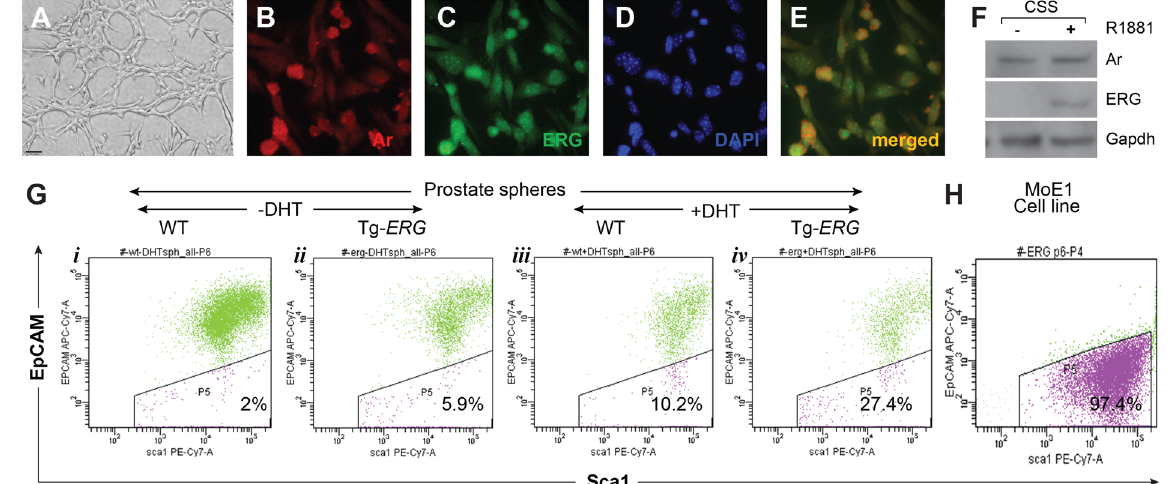
Figure 9. Spontaniously immortalized Tg- ERG mouse prostate epithelial cell line and epithelial cells isolated from Tg- ERG derived prostate spheres show similar features. Spontaniously immortalized Tg- ERG mouse prostate epithelial cell line, MoE1 (p6) grown in PrEGM supplemented with 1nM R1881 ( A–E ) show expression of both Ar ( B ) and ERG ( C ) by immunofluorescence using AR and ERG antibodies. Dapi ( D ) and Ar + ERG merged images ( E ) show colocalization of Ar and ERG in the muclei of MoE1 cells. Western blot analysis of MoE1 cells grown in charcoal stripped serum containing media show the expression of ERG upon induction with 1 nM R1881 ( F ). FACS analysis based on EpCAM of cells dissociated from the prostate spheres grown from wild-type, Tg- ERG mouse prostates in the absence ( G i, ii ) and presence of 10 nM DHT ( G iii, iv )